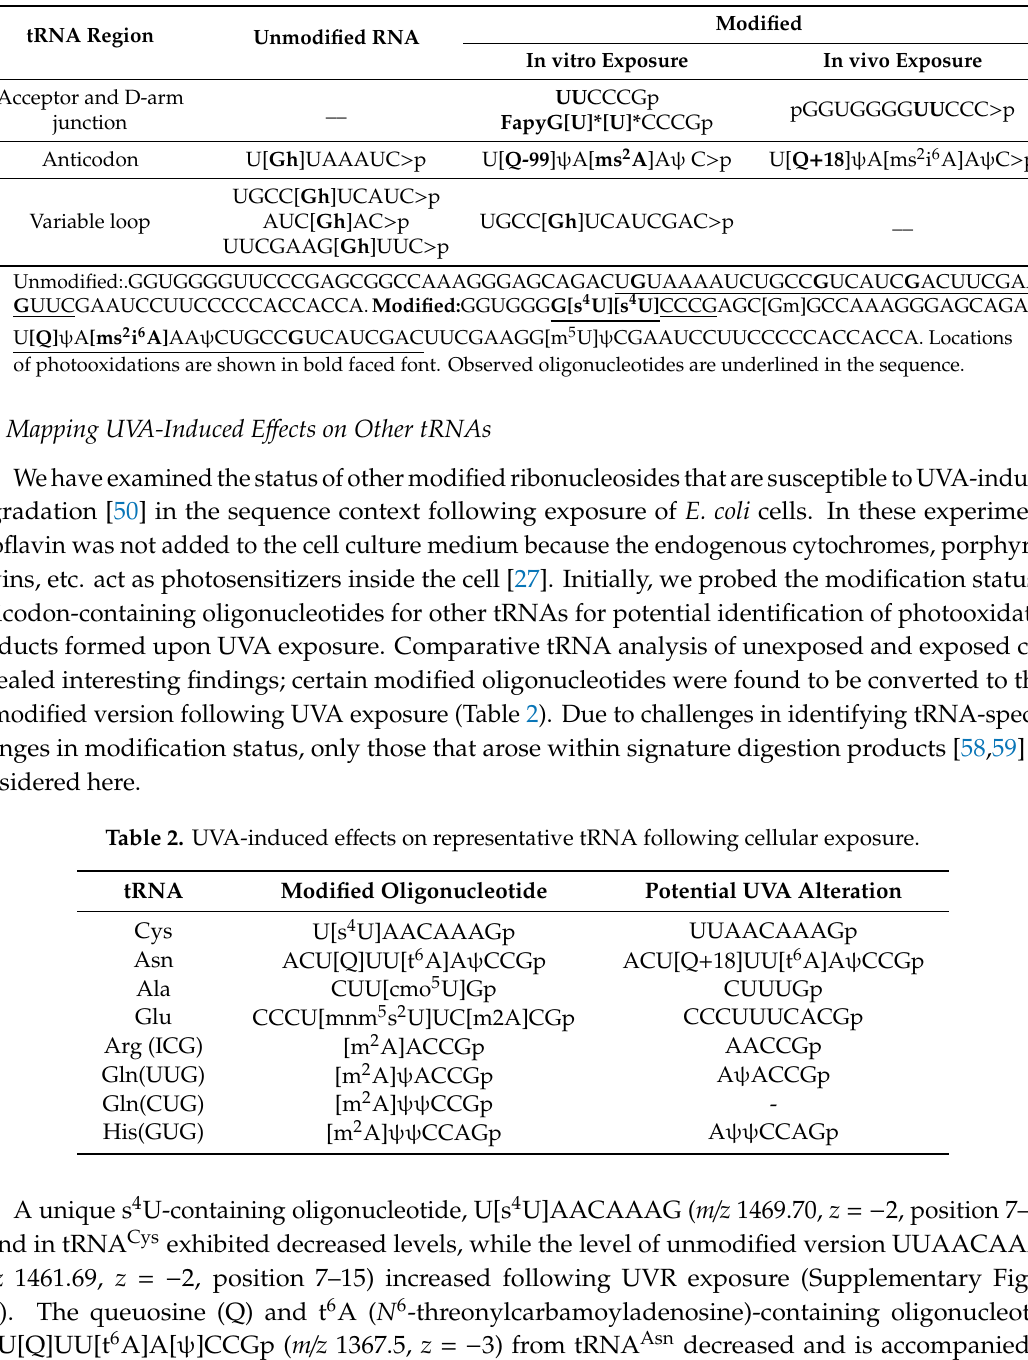
Table 1. UVA-induced alterations to tRNA Tyr oligonucleotides.